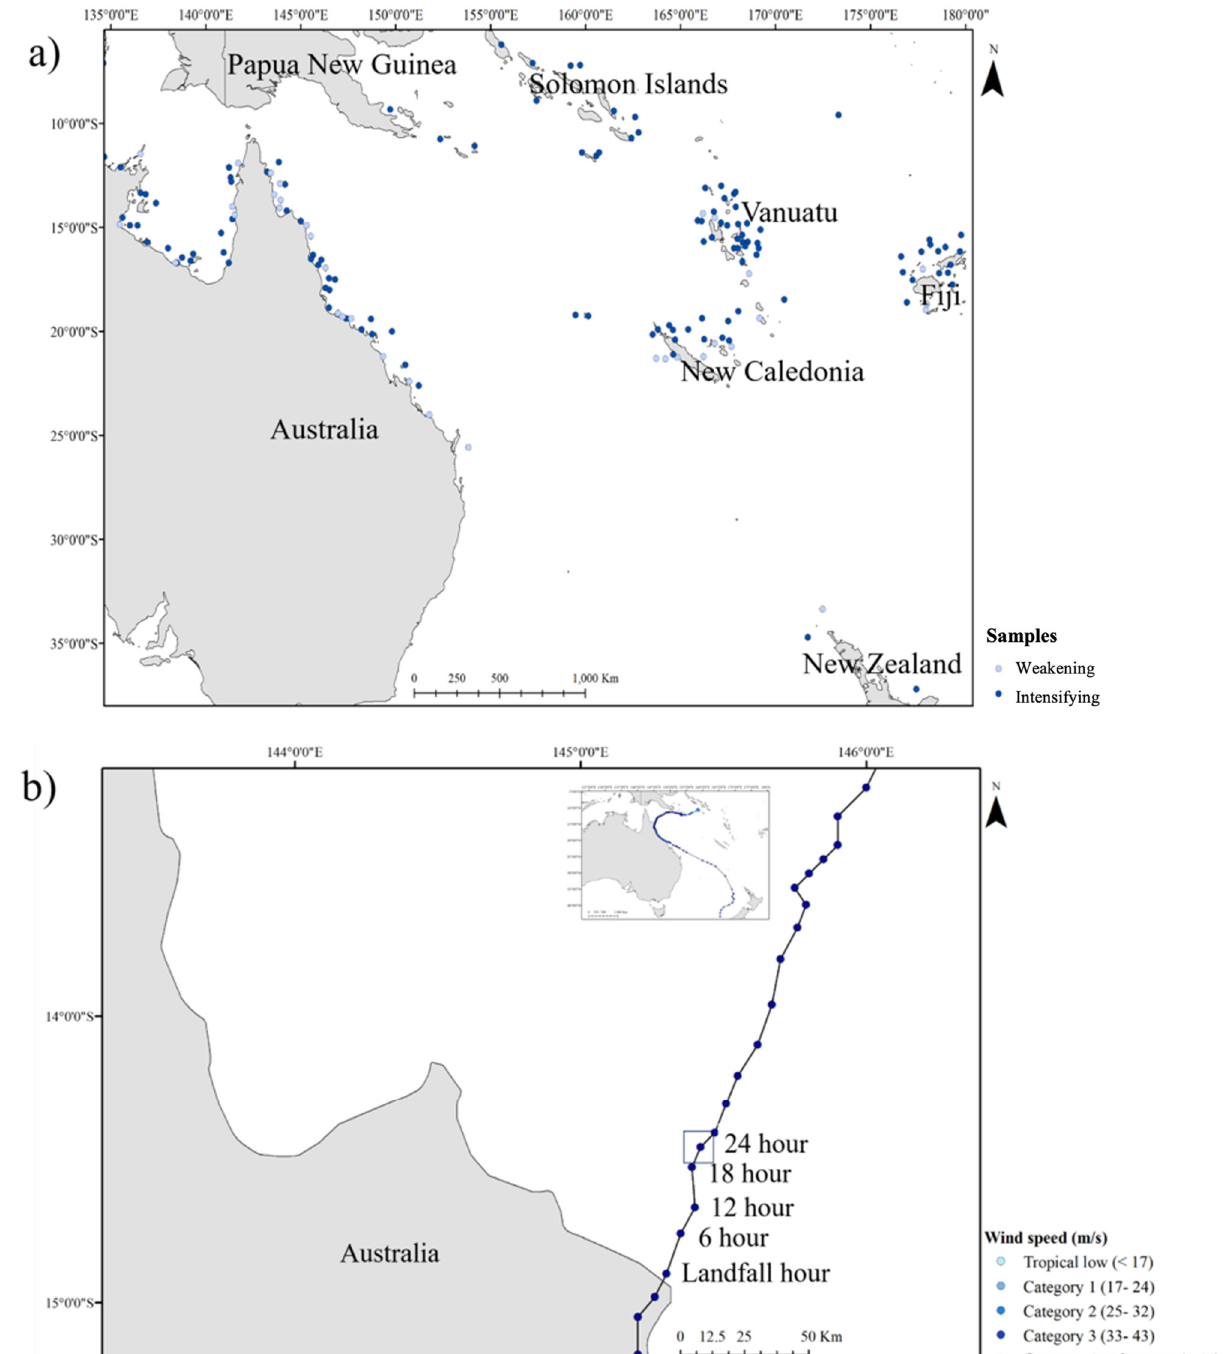
Figure 2. a ) Weakening and intensifying samples collected using Vmax change at the landfall hour from the 24 ‐ hour position for each storm, and b ) process of collecting aerosol and geophysical variables closest to the 24 hrs prior to landfall for each sample. The blue square box represents 24 hrs prior to landfall TC position. TC Ita was used to showcase the data collection process (full track image inset). TC Ita made its first landfall as a category five storm (Vmax 90 ms ‐ 1 ) on April 11th, 2014, near Cape Flattery, North Queensland. Table 1. Aerosol and geophysical input variables used in the machine learning algorithms. The table includes the spatial resolution (excluding latitude and longitude) and source of each variable . Variables Spatial Resolution Sources